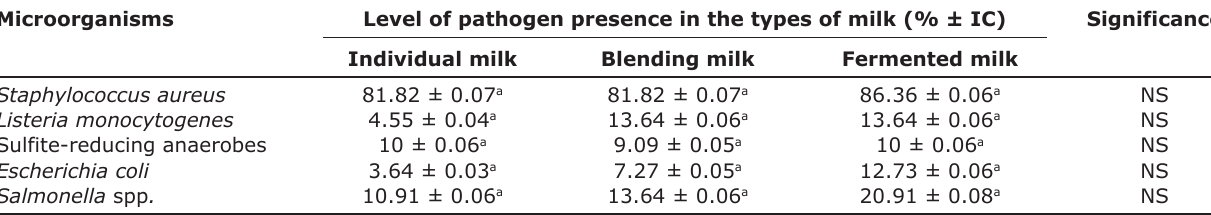
Table-6: Level of contamination of milk by pathogenic microorganisms. Microorganisms Level of pathogen presence in the types of milk (% ±